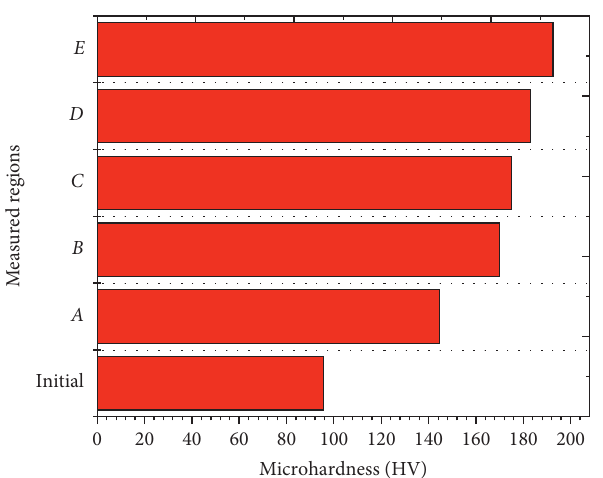
Figure 13: Microhardness distribution of the formed component in the annealed